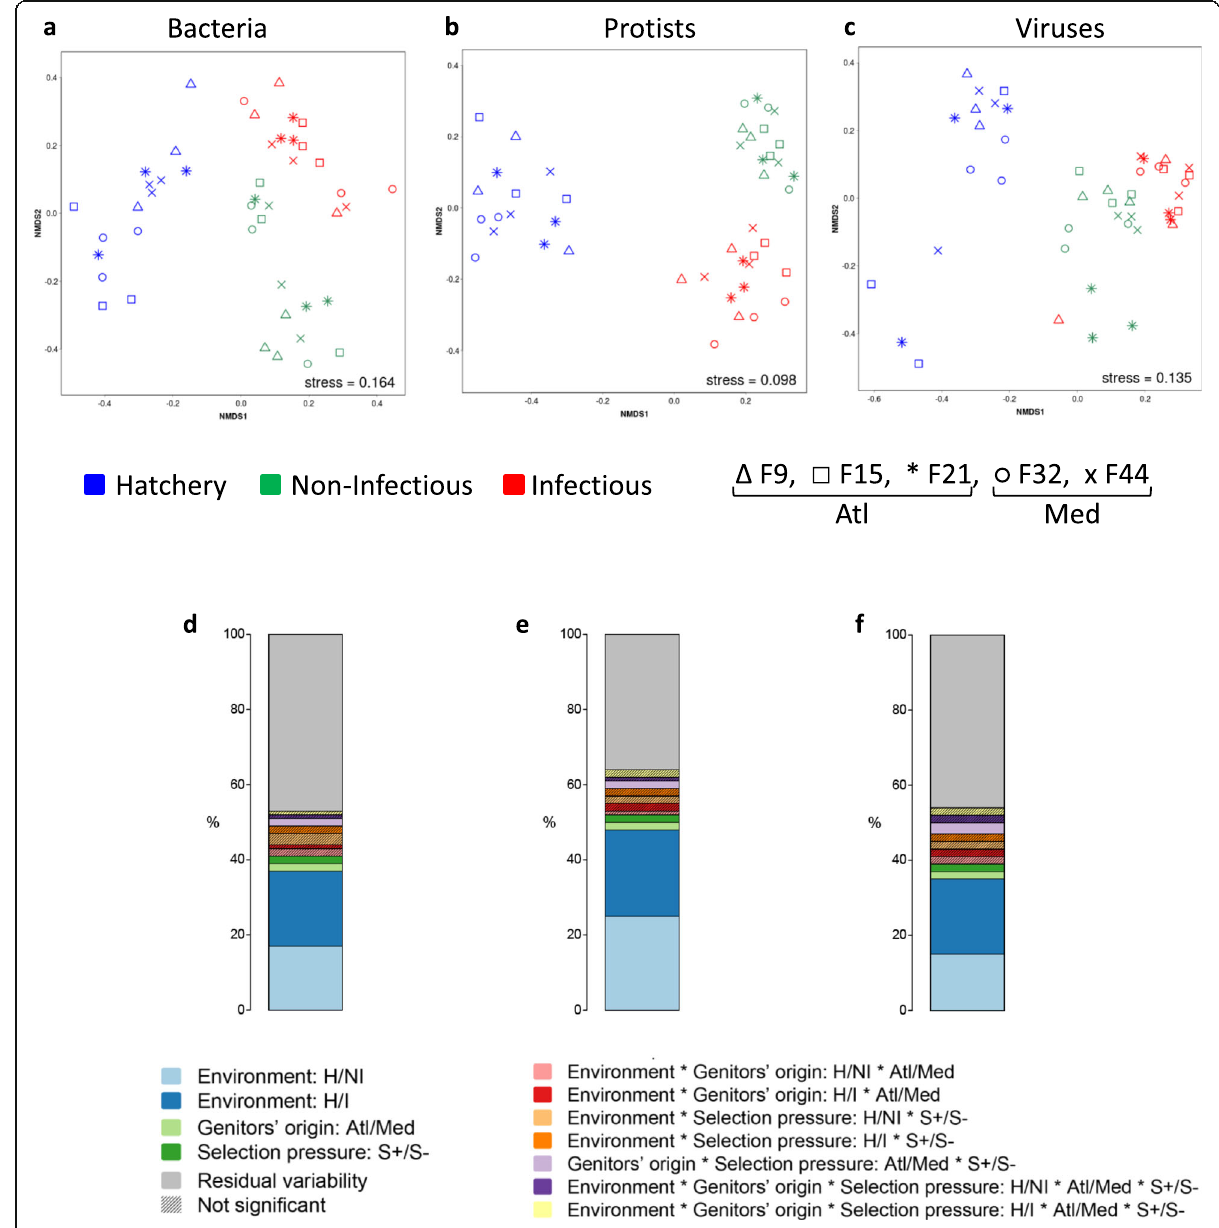
Fig. 5 Effect of oysters genetic background and environmental conditions on oyster hemolymph microbiota structure in controlled and natural conditions. NMDS plots of Bray-Curtis dissimilarities for the bacterial ( a ), protistan ( b ) and viral ( c ) communities in the hatchery, and natural non- infectious and infectious environments. Bar plots are graphical representations of Permanova results for the bacterial ( d ), protistan ( e ) and viral ( f ) communities. Permanova model fit here is ~ environment*genitors ’ origin *selection pressure (table on which the barplots are based can be found in Additional File 12: Table S11). The terms which are not significant are shown as shaded rectangles (for completeness), but should not be interpreted. Each term is described by the factor or interaction (interactions are marked by *) it represents (i.e. environment, environment * genitors ’ origin … ), followed by a specific contrast after the colon. Each term is more similar to a linear model coefficient (although it describes the variability explained), and is different from the shared amount of variability explained in redundancy analysis. Bacterial and protistan